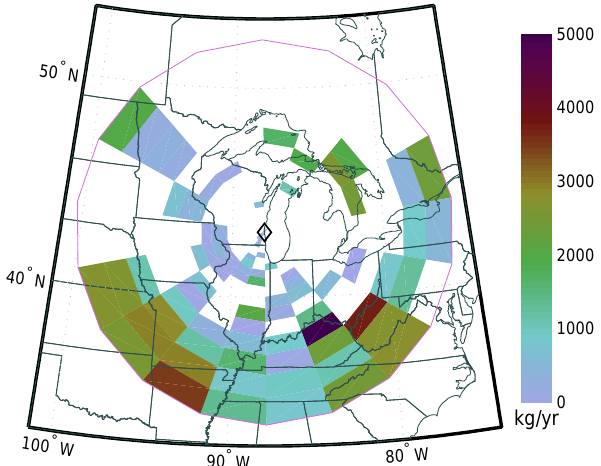
Fig. 8. Map of inverse gridded emissions showing the median of 100 bootstrapped runs. Extent of the back-trajectory grid used for the inversion shown in pink. Areas with zero emissions shown in white.